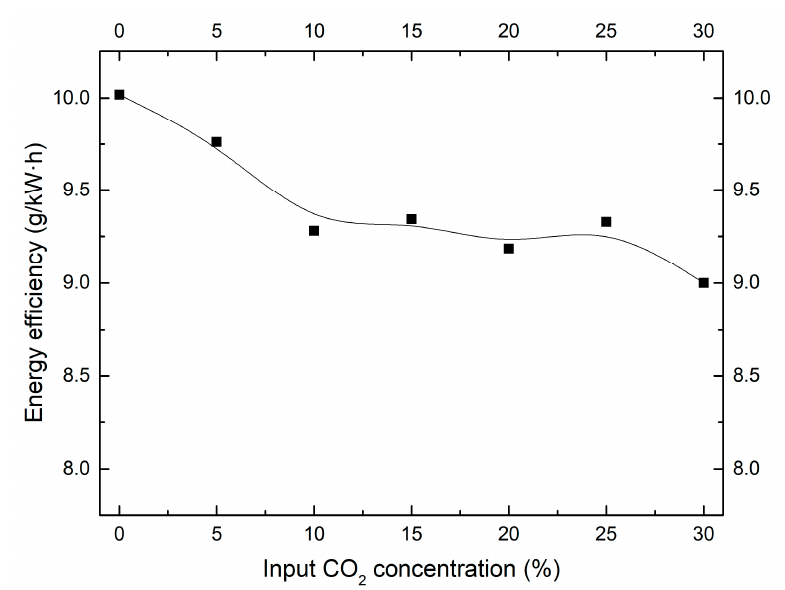
Figure 12. Effect of CO 2 concentration on energy efficiency.